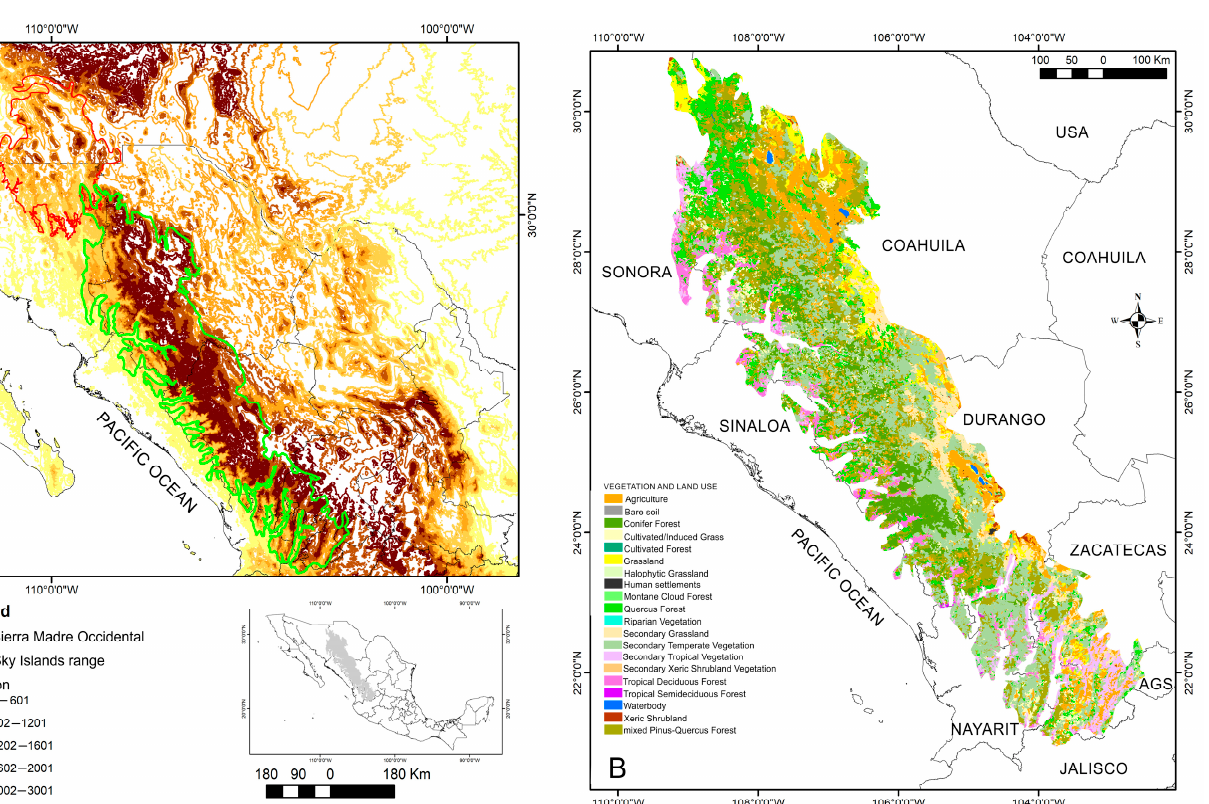
Figure 1. Map of northwestern Mexico. ( A ) Localization of the Sierra Madre Occidental (SMOc) and Sky Islands [33] and ( B ) vegetation types and land use in the SMOc [38]. AGS = Aguascalientes.